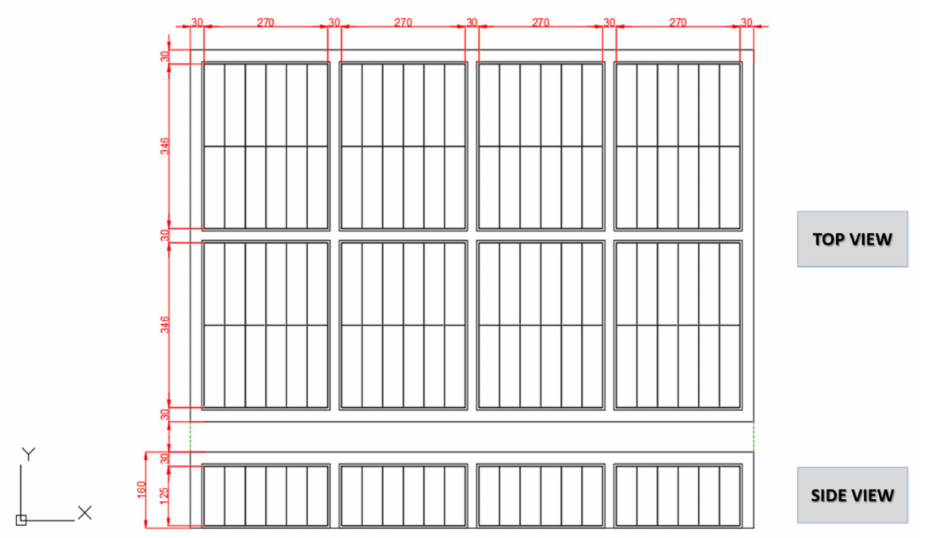
Figure 3. BMWi3 battery pack schematic (reference) in floor integration installation (configuration